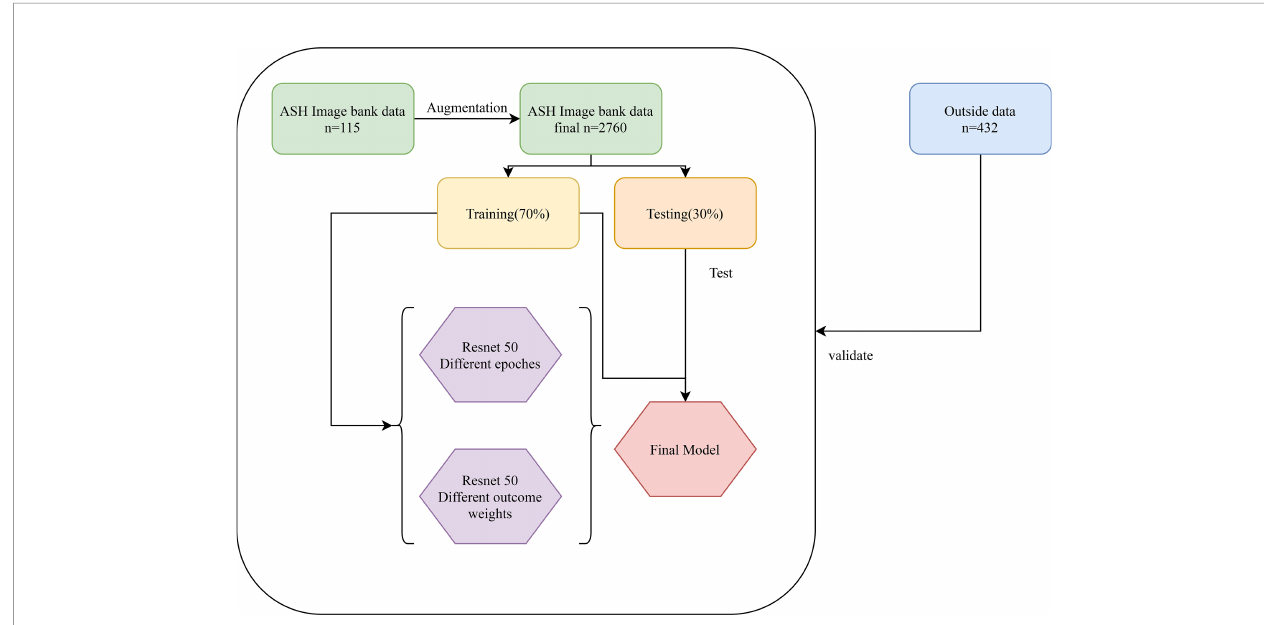
FIGURE 4 | The construction process of the recognition